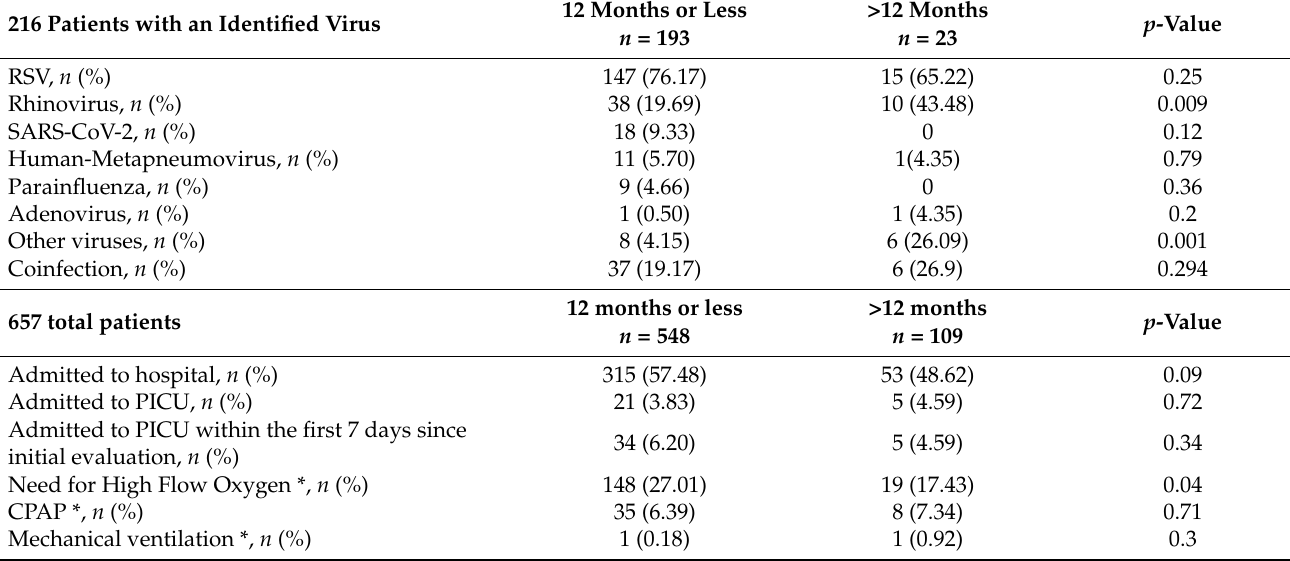
Table 5. Disease severity according to age. CPAP, continuous positive airway pressure; HFNC, high-flow nasal cannulae; PICU, pediatric intensive care